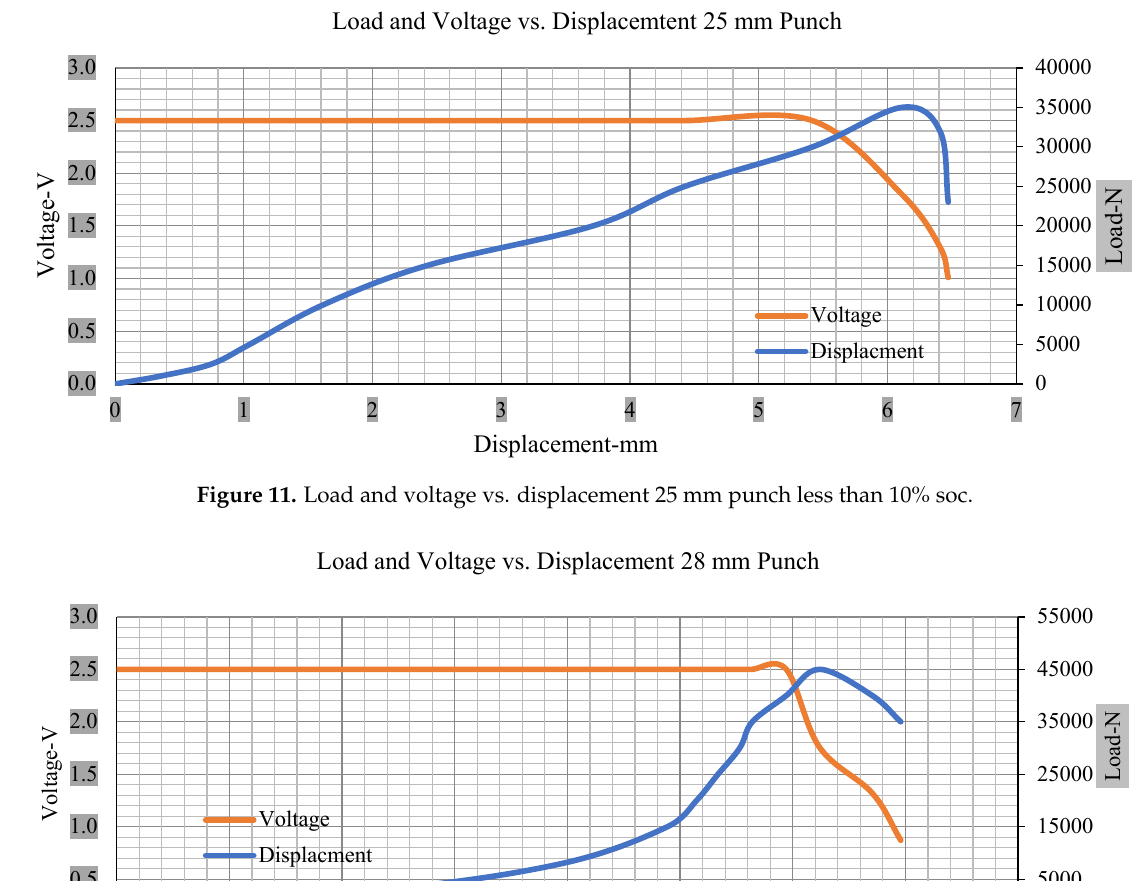
Figure 10. Load and voltage vs. displacement 12 mm punch less than 10% soc.